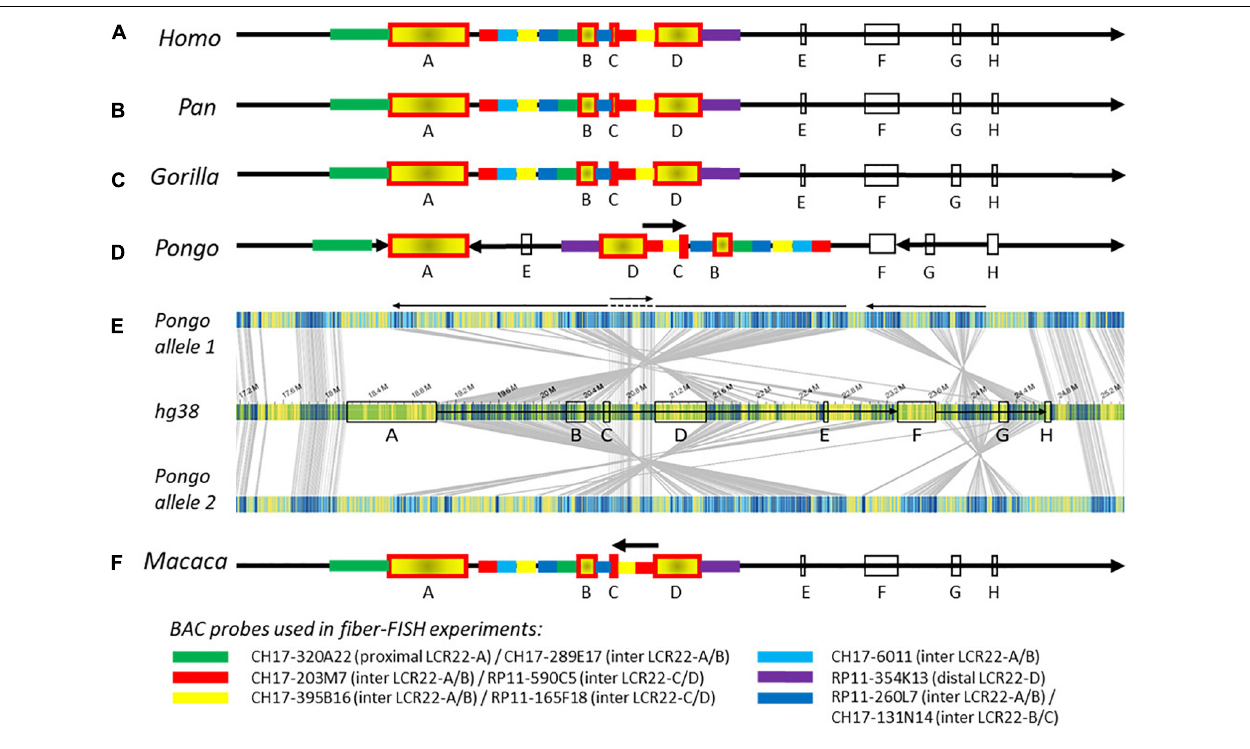
FIGURE 2 | Composition of the 22q11.2 locus in human and non-human primates. Schematic representations of the 22q11.2 region, including LCR22-A through –H, based on Bionano optical mapping and fiber-FISH. As represented in (A) the human reference genome hg38, (B) chimpanzee and bonobo, (C) gorilla, and (D) orangutan. (E) Bionano optical mapping results of orangutan compared to the human reference genome. The middle bar represents the human hg38 reference genome with blocks indicating the LCR22s (corresponding to A ). The top and bottom bar represent the assembled haplotypes for this orangutan. Gray lines between the maps indicate orthologous loci. Blue labels in the maps are aligned labels, and yellow labels unaligned. These unaligned labels are non-similarities between the genomes. They can be present either at the nucleotide level or in very complex regions as segmental duplications. Arrows below depict rearrangements between the human and the orangutan genomes. (F) Schematic 22q11.2 representation of the rhesus monkey, only based on fiber-FISH results. Chromosomal locations of the BAC probes can be found in Supplementary Table 2 . Cartoons are not to